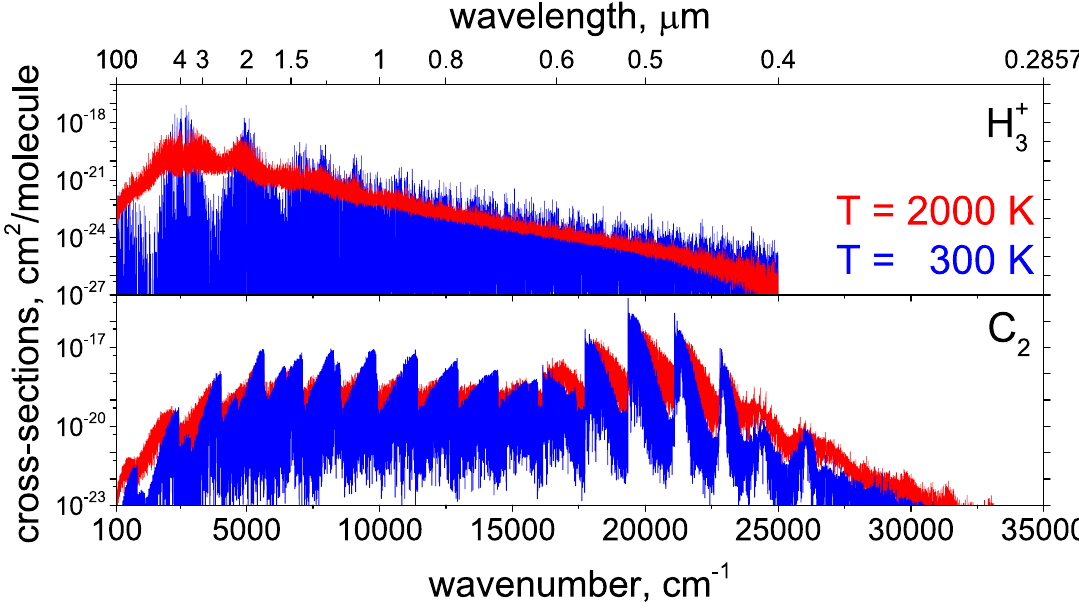
Figure 15. Cross sections based on ExoMol line lists for carbon dimer [77] and H +